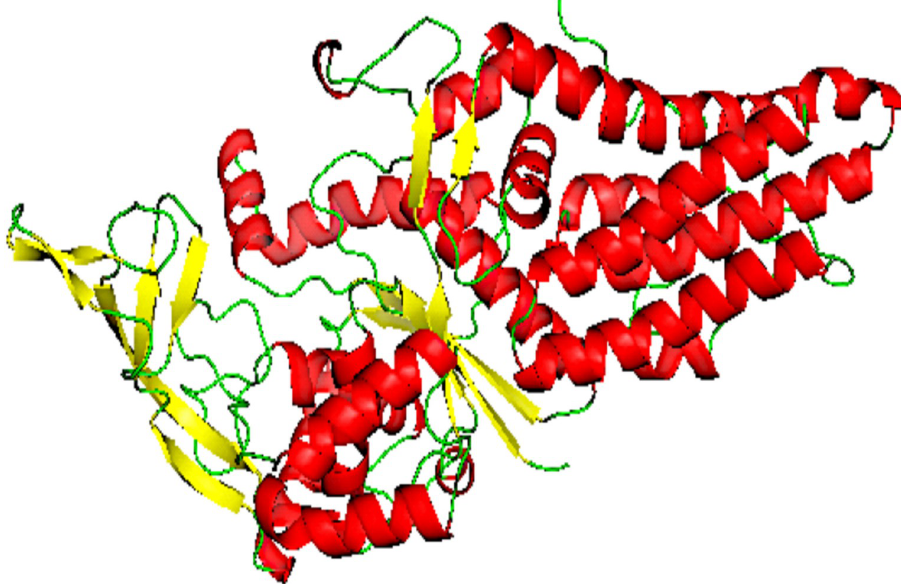
Fig 1. The cartoon structure of modeled BrMelMetRS. Beta sheets in yellow, alpha helix in red, and loops in green.